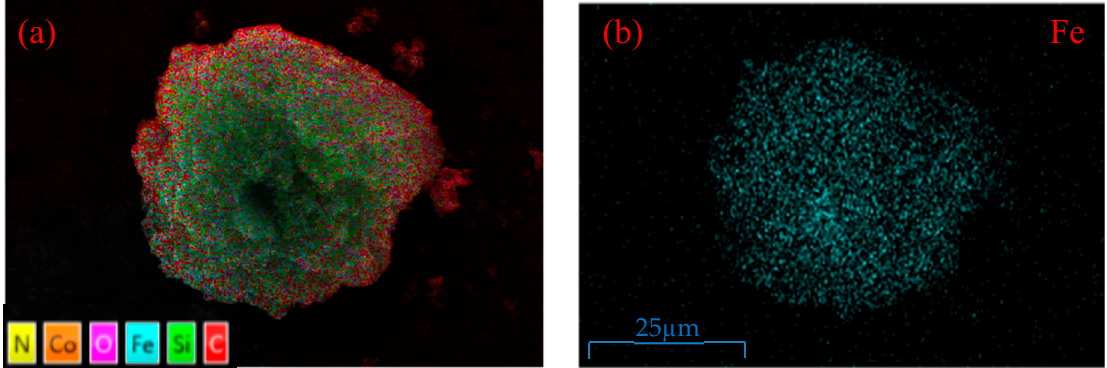
Figure 4. Energy-dispersive spectrometry (EDS) elemental analysis of CoFe 2 O 4 @SiO 2 -Ppy.